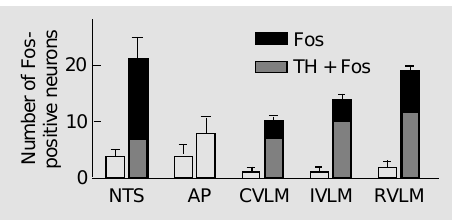
Figure 5. Number of Fos-posi- tive neurons per section in dif- ferent hindbrain regions after fourth ventricle administration of Ang II (4-8 pmol/min, filled bars) or Ringer’s solution